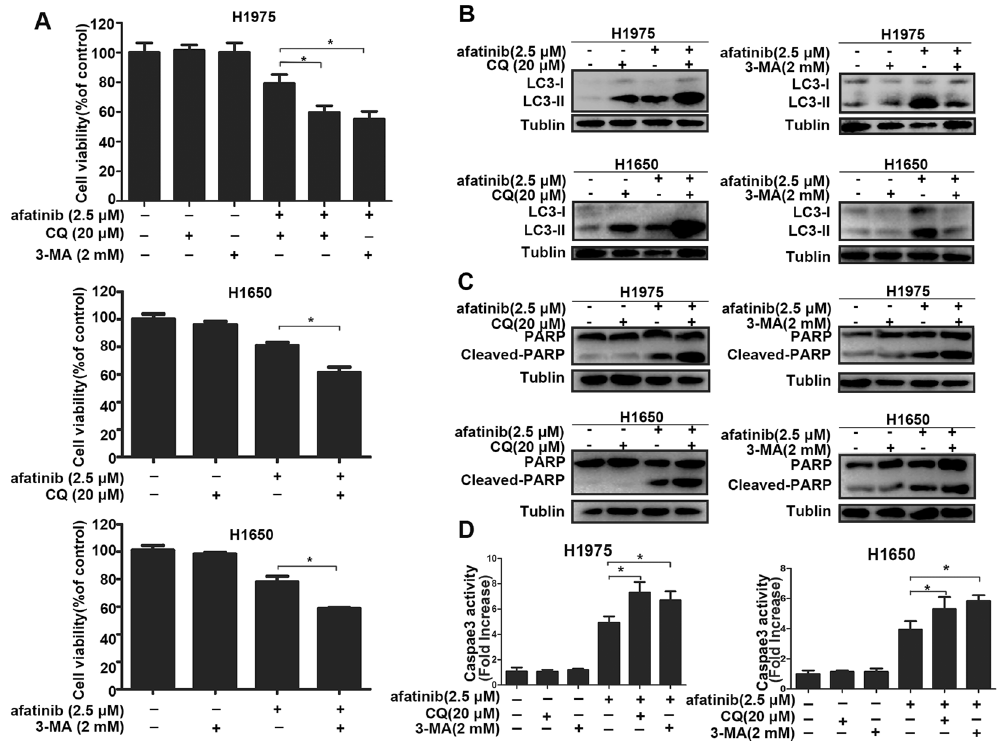
Figure 5. Suppressing of afatinib-induced autophagy promotes the growth inhibition and apoptosis in H1975 and H1650 cells. ( A – D ) H1975 and H1650 cells were stimulated by 2.5 μ M afatinib in the presence or absence of 20 μ M CQ or 2 mM 3-MA for 48 h. ( A ) Cell viability was measured by MTT assay. ( B ) LC3-I/II production were measured by western blot analysis. These blots were cropped with Photoshop CS6. ( C ) Western blot analysis was used to measure the level of PARP and Cleaved-PARP. These blots were cropped with Photoshop CS6. ( D ) The activity of caspase 3 were detected by caspase 3 activity kit. All these data were presented as mean ± SD ( * P <